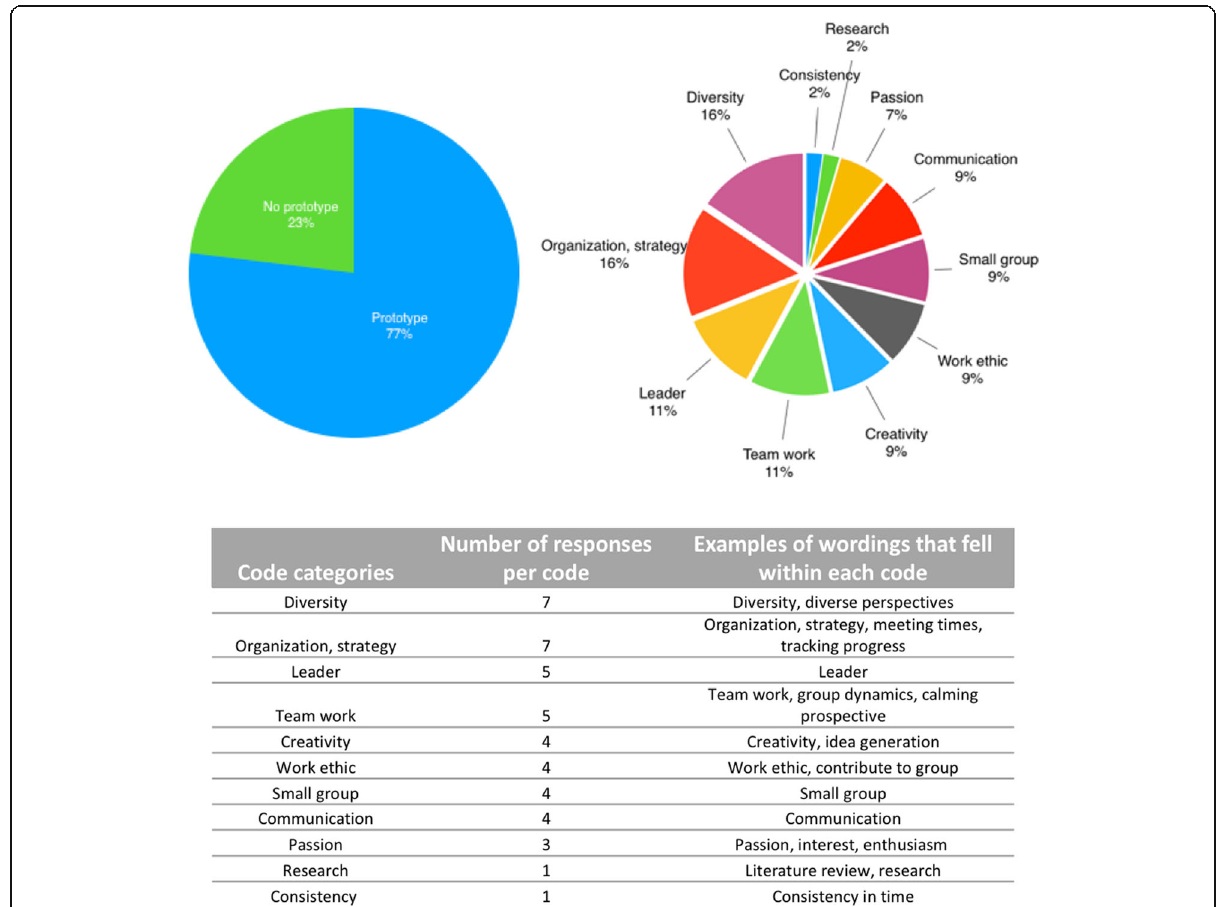
Fig. 5 Interview results. Thirteen students were interviewed. The average size of their VIX groups was 4.1 students. Three out of 13 students did not complete prototypes for their VIX project(s), demonstrating that the majority of students interviewed completed the program as intended until that step in the process. From the interviews, students highlighted some key areas related to successful VIX projects, including teamwork, organization, leadership, creativity, work ethic, small groups, communication, passion, research, and consistency. The code used to create this data and example wording from the interviews are listed in the